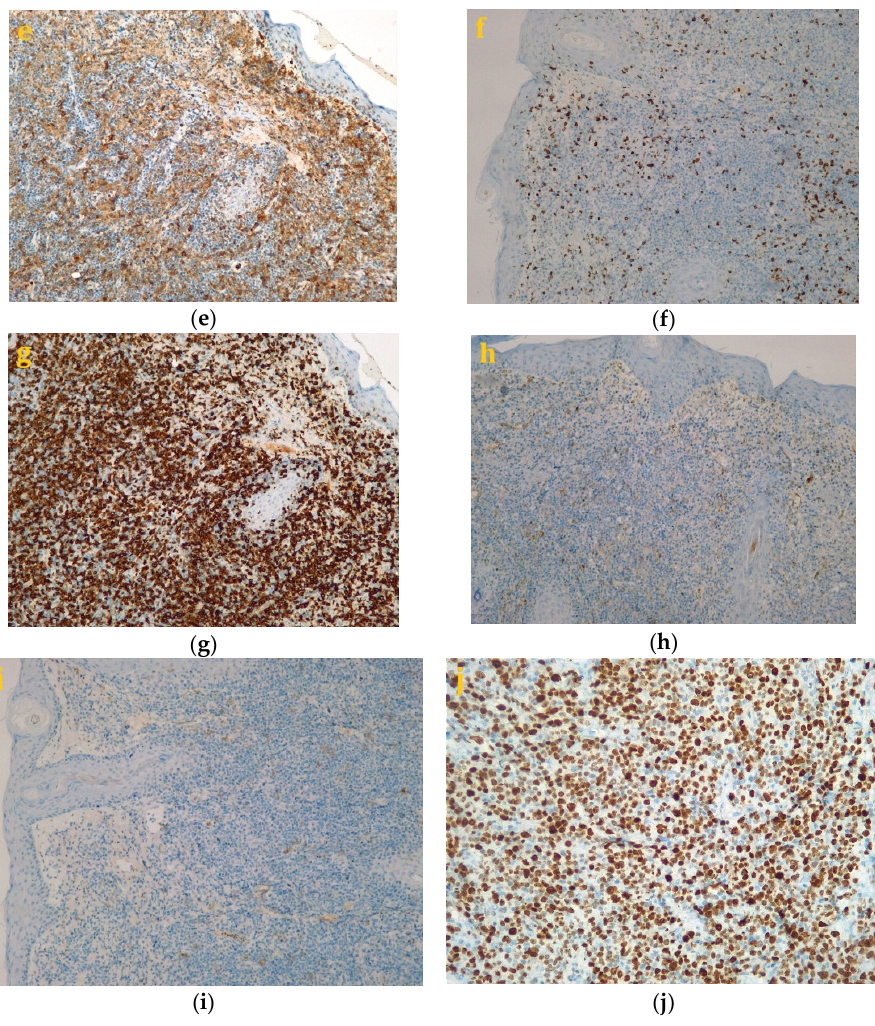
Figure 3. Immunohistochemistry staining for the following markers: CD20 ( a , Magnification 200×), CD3 ( b , Magnification 200×), CD5 ( c , Magnification 200×), CD2 ( d , Magnification 200×), CD4 ( e , Magnification 200×), CD8 ( f , Magnification 200×), CD7 ( g , Magnification 200×), CD56 ( h , Magnification 200×), CD30 ( i , Magnification 200×), Ki-67 ( j , Magnification 200×).